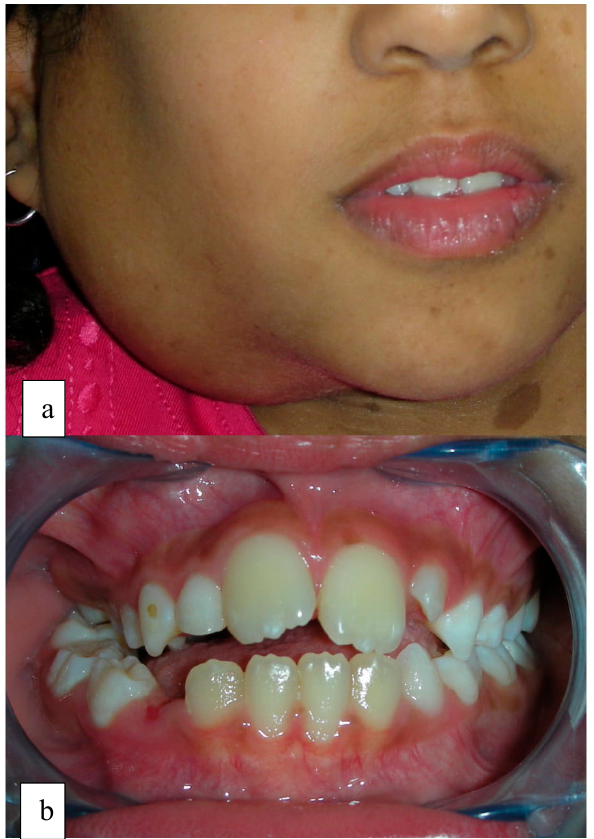
Figure 3. ( a ) Neurofibroma in the head and neck region; ( b ) class III malocclusion and posterior cross-bite in NF I patient.